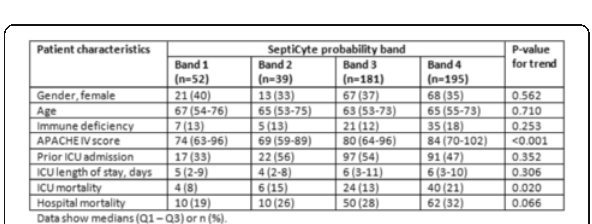
Fig. 2 (abstract A6). Patient characteristics by SeptiCyte LAB result